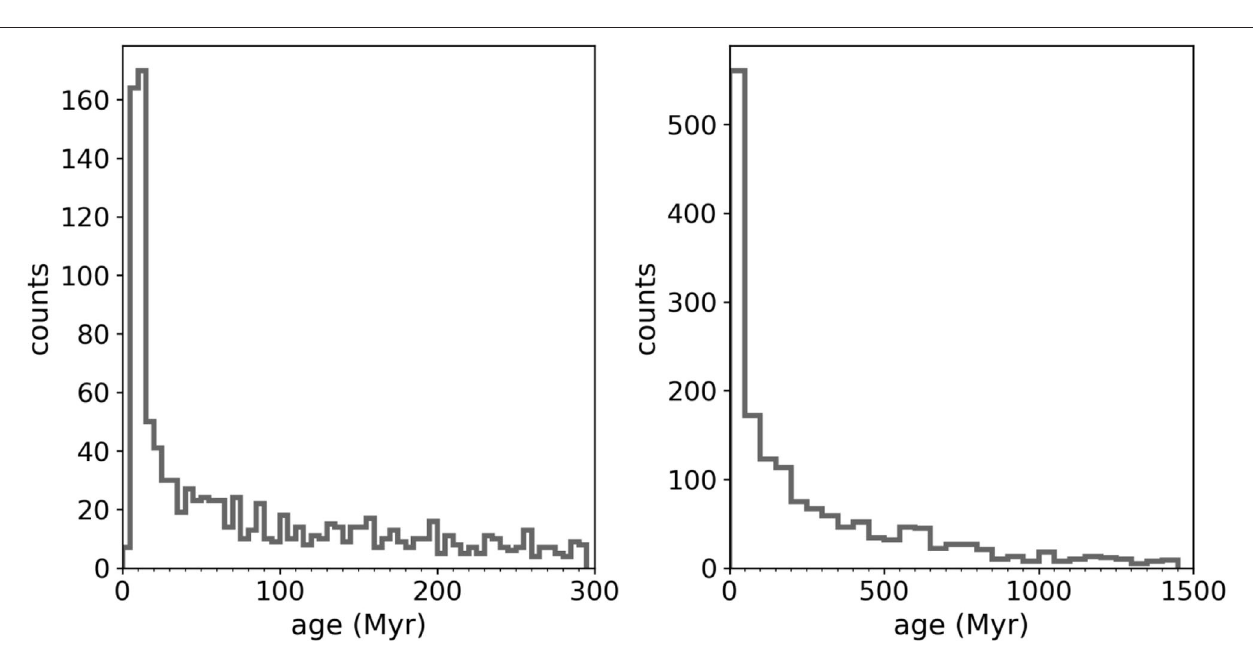
FIGURE 3 | The age distribution of the open clusters of our total sample. Two time-scales are presented, with bin width 5 Myr, extending to 300 Myr (left plot) and with bin width 40 Myr, extending to 1,500 Myr (right plot). The evolution of the number of clusters is quite smooth on the two